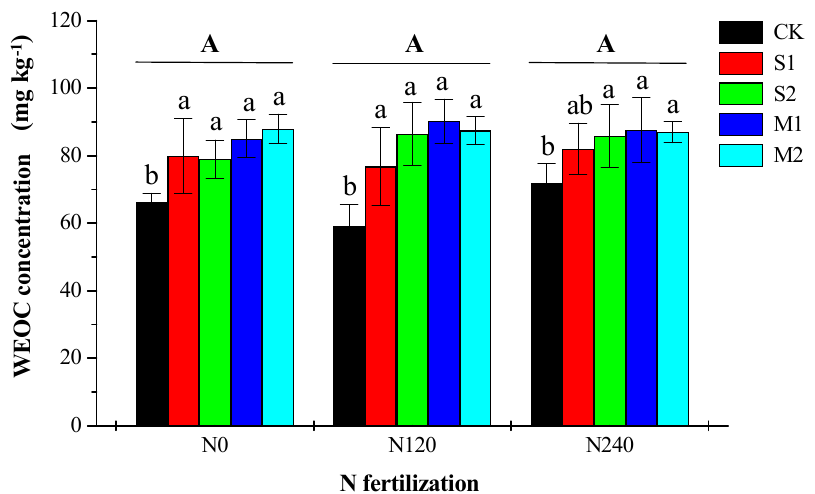
Figure 2. Water-extractable organic carbon (WEOC) concentrations under various carbon (C) and nitrogen (N) management treatments. Treatment abbreviations are defined in Figure 1. Different lowercase letters indicate significant differences among the five organic amendment treatments ( p < 0.05). Different uppercase letters indicate significant differences among the three nitrogen fertilization treatments ( p < 0.05).